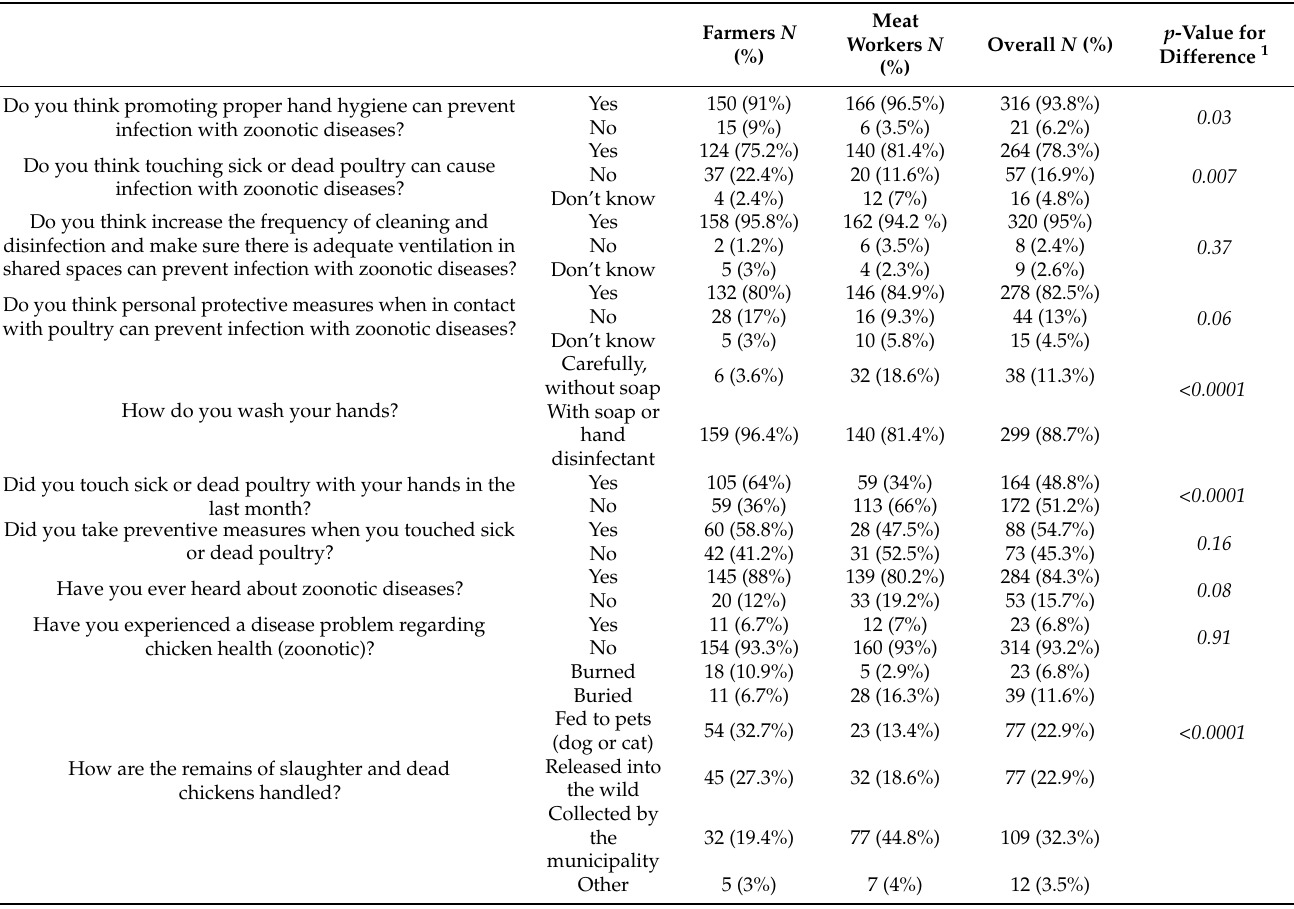
Table 2. Hygiene and zoonotic diseases-related knowledge and practices 1 .